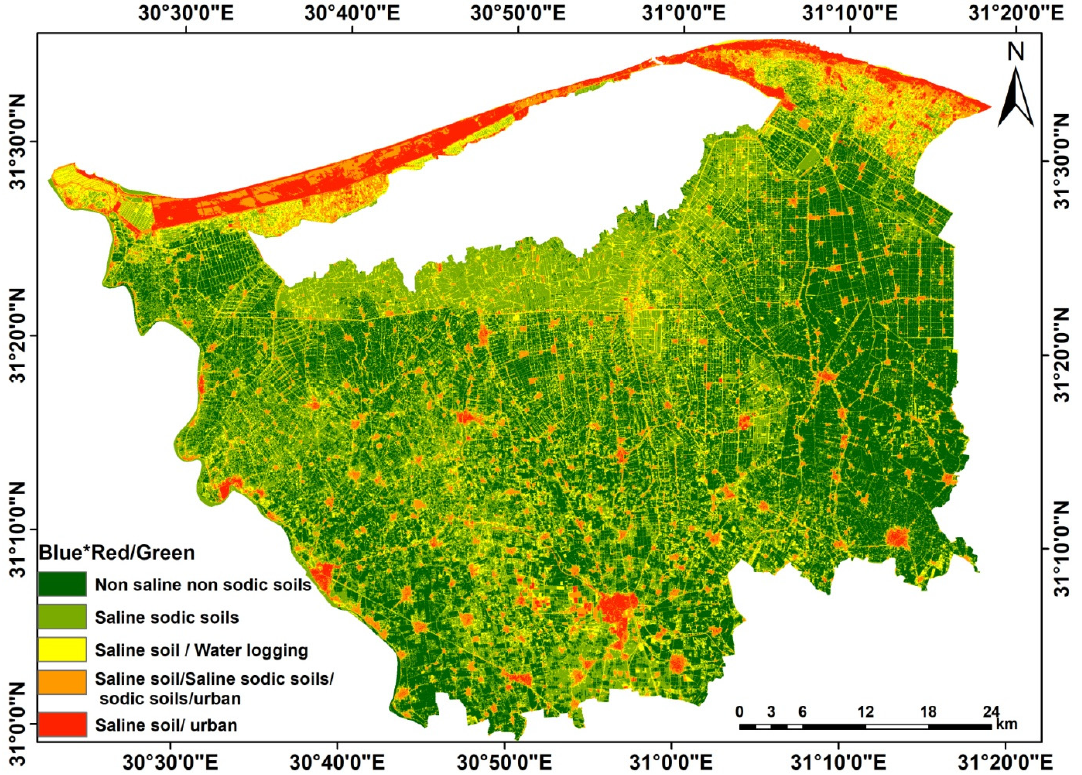
Figure 4 . 1st part of the equation (Blue * Red/Green) applied on 2021. Figure 4. 1st part of the equation (Blue * Red/Green) applied on